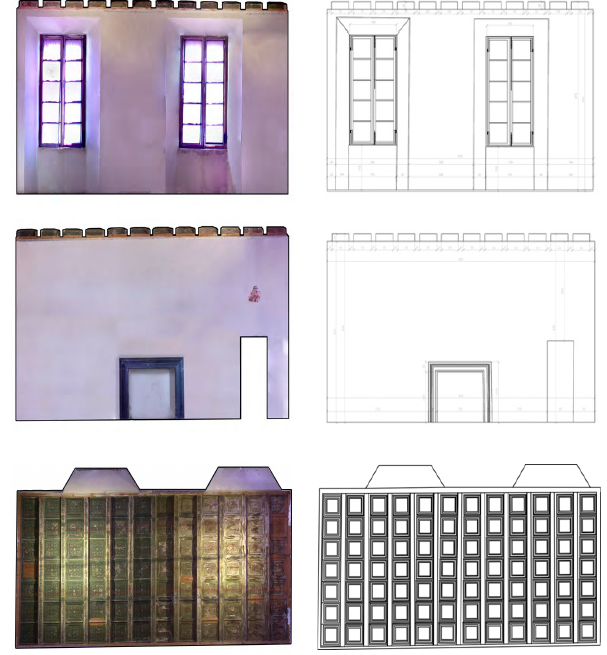
Figure 11. Sections of the room (by photos and by lines) and ceiling coming from Photoscan projections